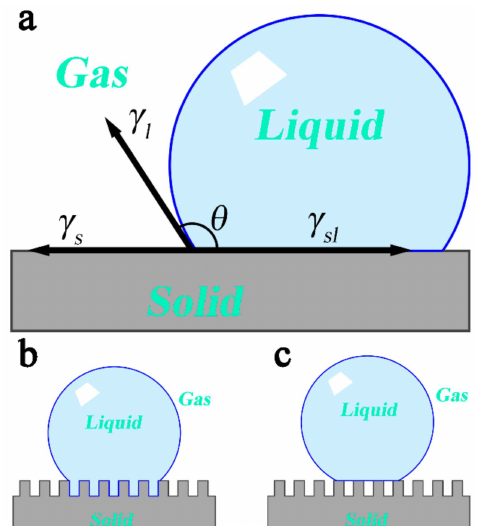
Figure 1. Schematic of a liquid droplet on solid surface. ( a ) Young’s wetting state; ( b ) Wenzel wetting state; ( c ) Cassie–Baxter wetting